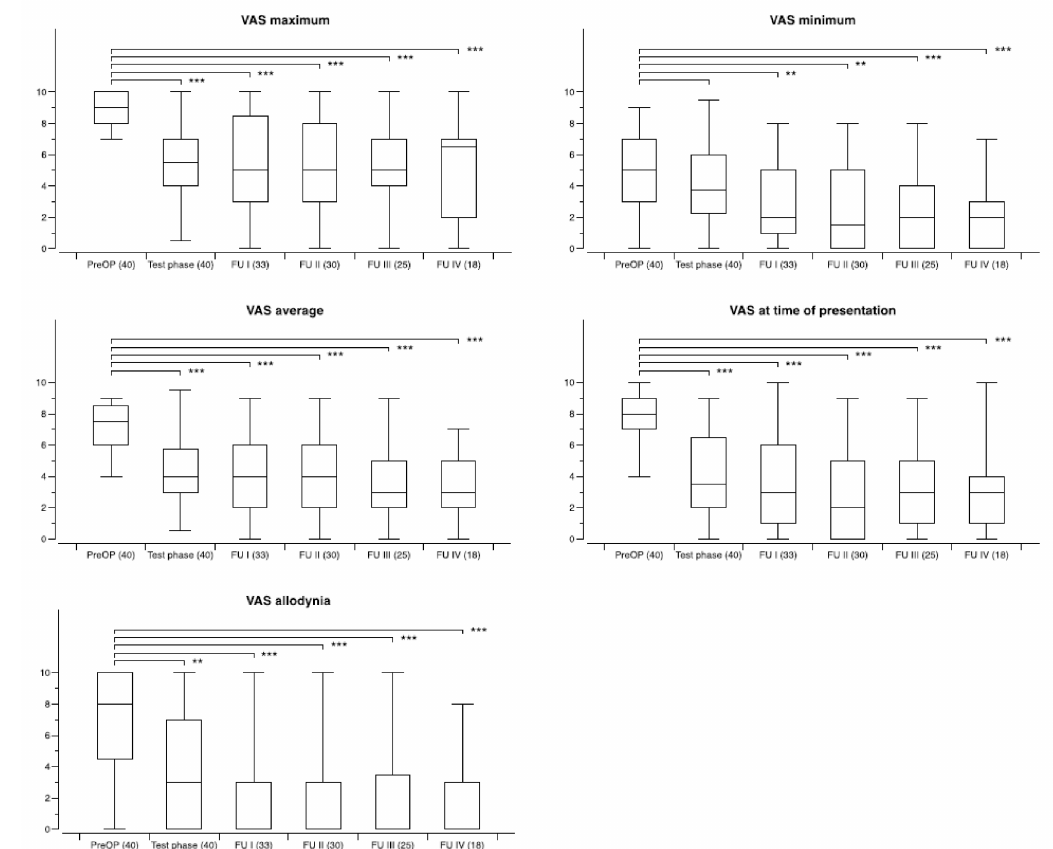
Figure 2. Development of specific VAS pain scores during chronic thalamic stimulation in 33 patients with various neuropathic pain syndromes. The number of patients available at the different time points is shown in brackets.